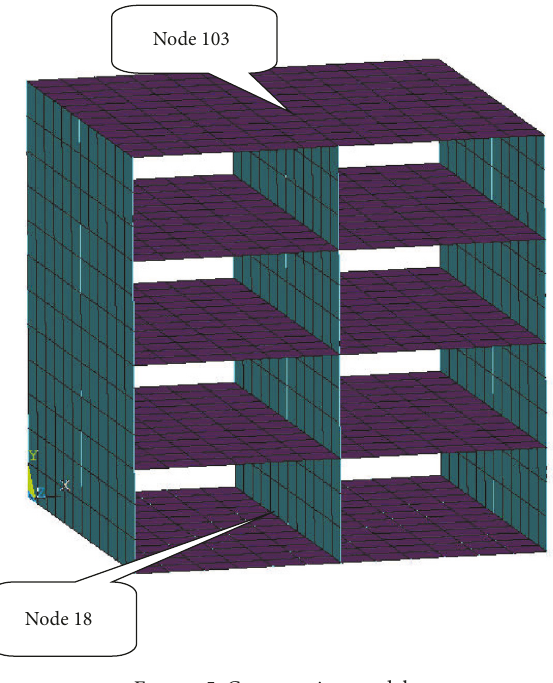
Figure 5: Computation model.